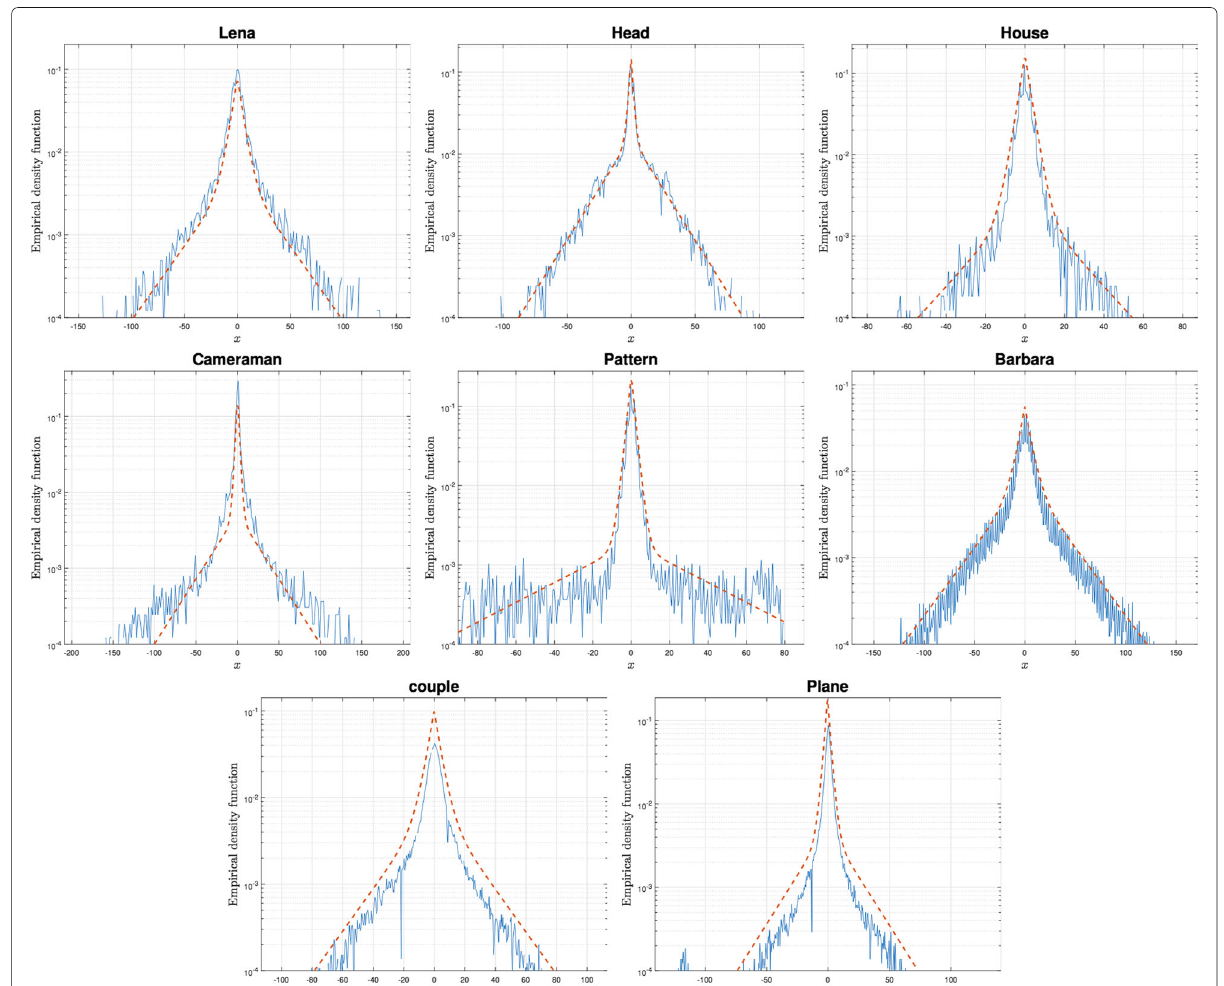
Fig. 4 Experiment 2: empirical density function in the log domain of a single vertical wavelet subband coefficients of natural images (solid). The dashed line represents the best fitting of the mixture of two Laplace density functions computed by maximizing the likelihood of the data